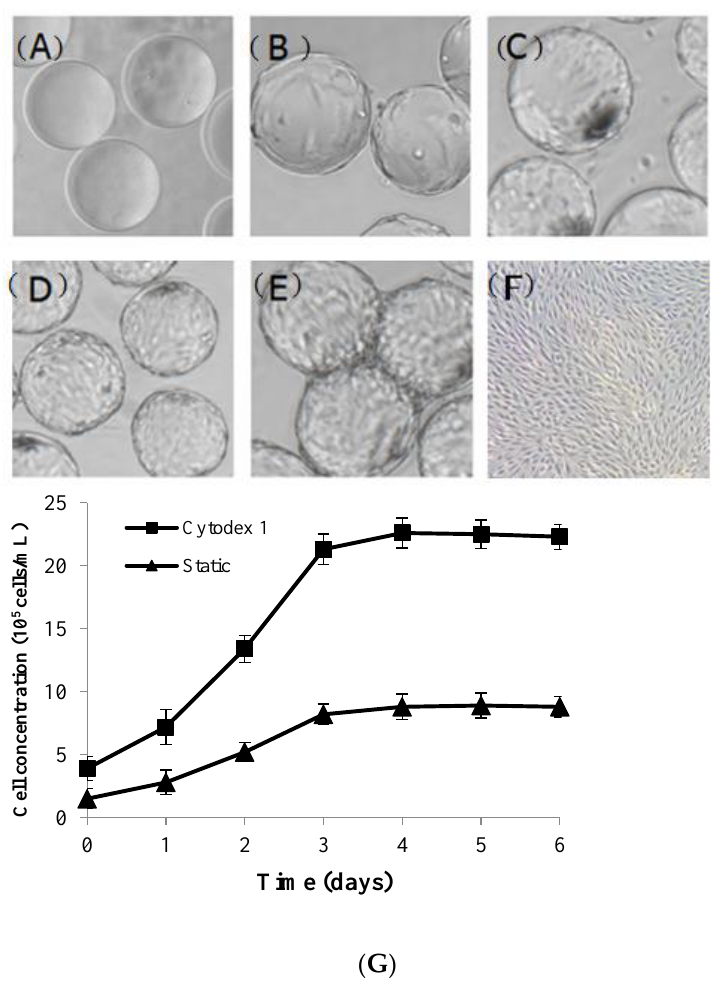
Figure 8. Characteristics of CPB cells expanded under static and suspended culture conditions. ( A – F) Morphology of the cells grown on Cytodex1 and culture plate (20×) ( A ) Bare microcarrier; ( B ) Cell attachment on the first day; ( C ) 50% of the microcarriers were coated with CPB cells on the second day; ( D ) Cells grew to a single-layer on the third day; ( E ) “cell bridge” appeared when cells were fully attached on Cytodex1. ( F ) CPB cells in the static culture plate; ( G ) Growth curve of CPB cells expanded under static and suspended culture conditions. Bars show the mean ± SD, n =3.